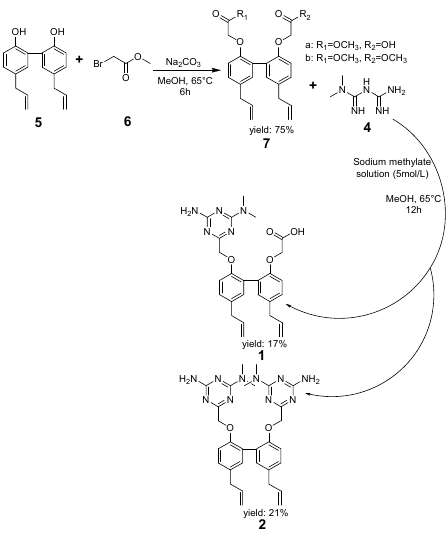
Scheme 1. Cyclization of compounds 1 and 2 .